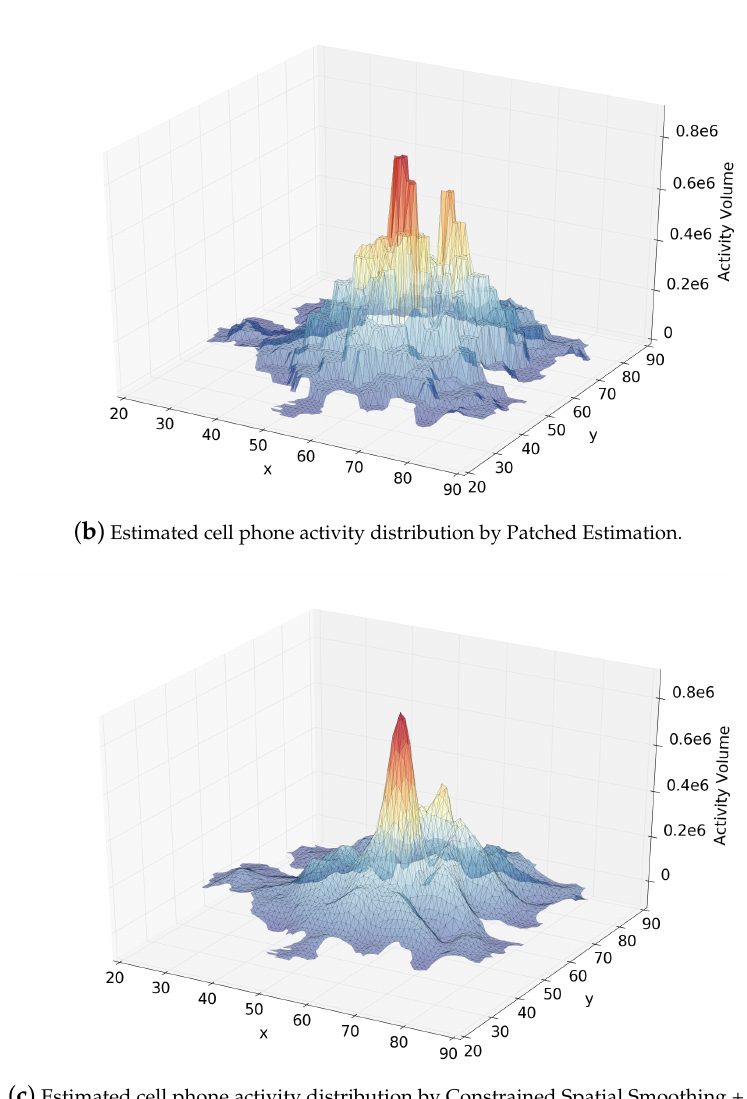
( c ) Estimated cell phone activity distribution by Constrained Spatial Smoothing + Features. Figure 6. Comparison of the activity distributions. ( a ) real cell phone activity distribution; ( b ) estimated distribution by Patched Estimation method; ( c ) estimated distribution by our